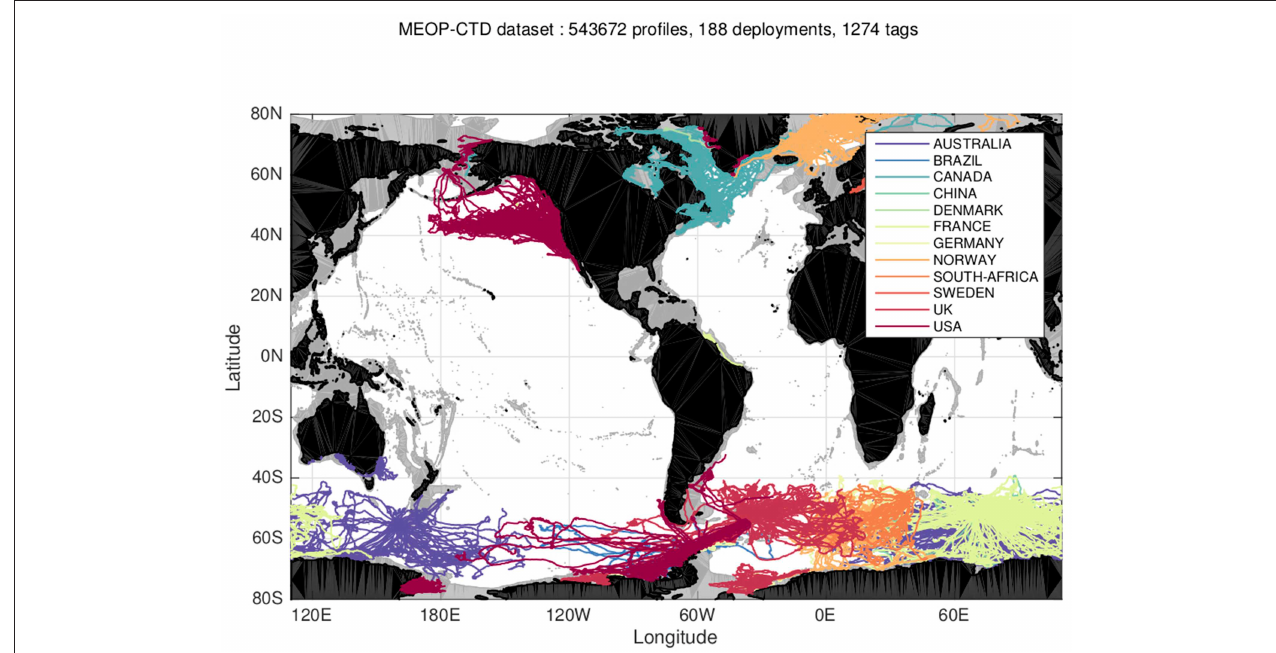
FIGURE 3 | Distribution of hydrographic profiles currently available in the MEOP-CTD database (November 2017 version, Source: meop.net).